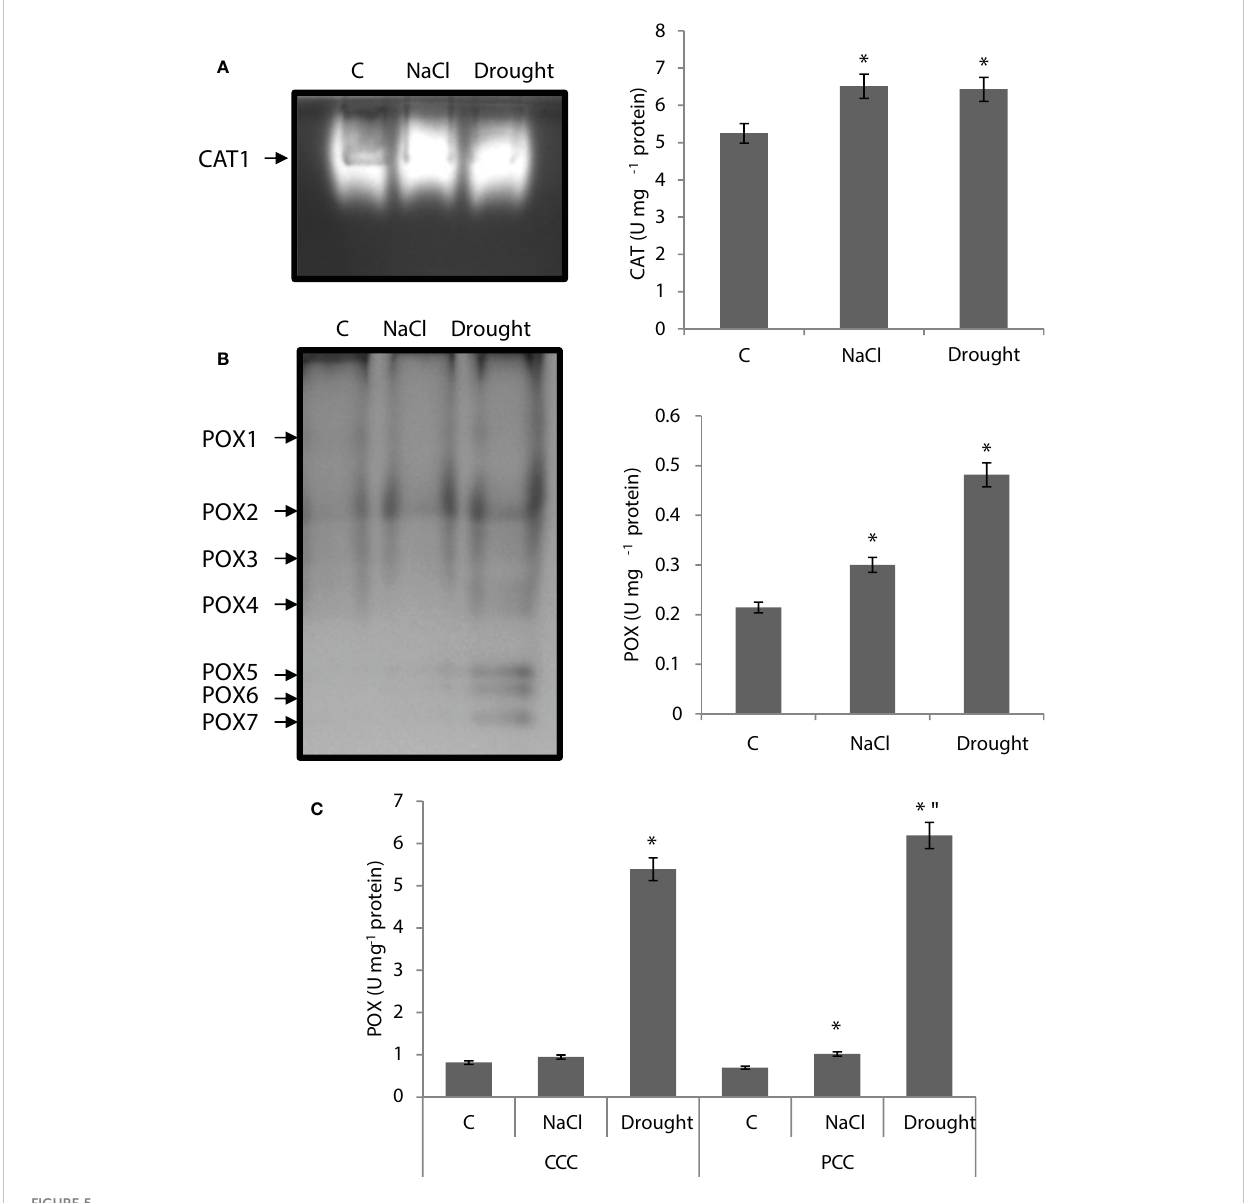
FIGURE 5 (A) Catalase (CAT) native activity gel and total CAT activity of whole leaves. (B) Peroxidase (POX) native activity gels and POX activity of whole leaves and (C) CCC and PCC of Bienertia sinuspersici treated with 400 mM NaCl or water withholding for 10 d. “ * ” indicates signi fi cant difference (p < 0.05) as compared to controls. For CCC and PCC groups are compared to their own controls. When effects of treatments are compared between CCC and PCC, signi fi cant differences are shown with “